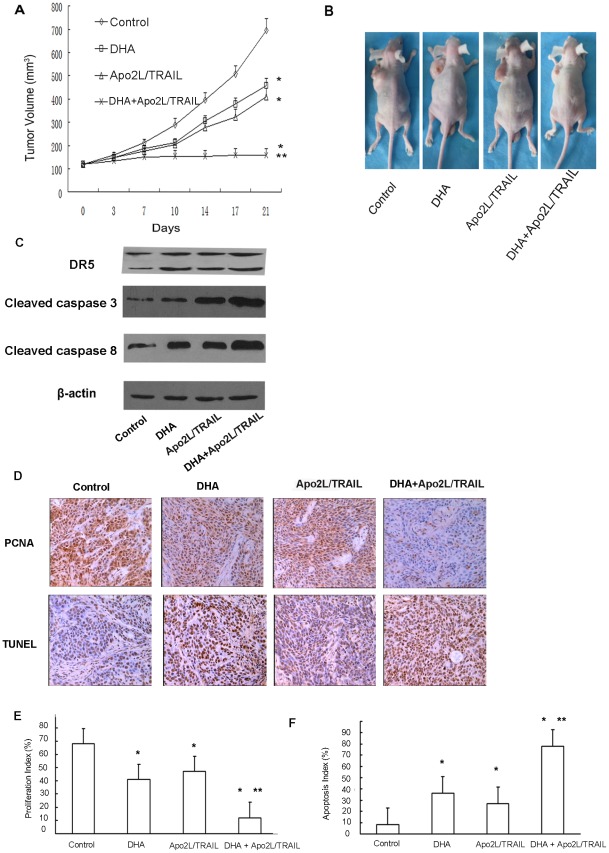
Tumor growth, tumor gene expression, tumor proliferation and apoptosis in vivo.(A) BxPC-3 tumors were established subcutaneously in mice. When the tumors reached approximately 120 mm3 in volume, the mice were randomly assigned to control, DHA, Apo2L/TRAIL, or DHA+Apo2L/TRAIL groups and treated as described in the methods section. The sizes (measured in mm3) of the tumors were monitored and recorded. A significant difference in tumor volume from the control is denoted by “*” (P<0.05), and a significant reduction compared to the DHA or Apo2L/TRAIL-treated tumors is denoted by “**” (P<0.01). (B) Representative animals and tumors are shown for each group. (C) Tumors from control mice and from mice treated with DHA, Apo2L/TRAIL, and DHA+Apo2L/TRAIL were homogenized and subjected to western blot analysis to detect the expression of caspase-3 and caspase-8. β-actin served as an internal control. (D) Analysis of proliferation marker PCNA by immunohistochemistry and apoptotic status of tumor cells by in situ TUNEL assay. PCNA positive (E) and TUNEL-positive (F) cells were also counted under microscope to calculate the proliferation index and apoptotic index, respectively. “*”: P<0.05, compared with control. “**”: P<0.01, compared with single agent.